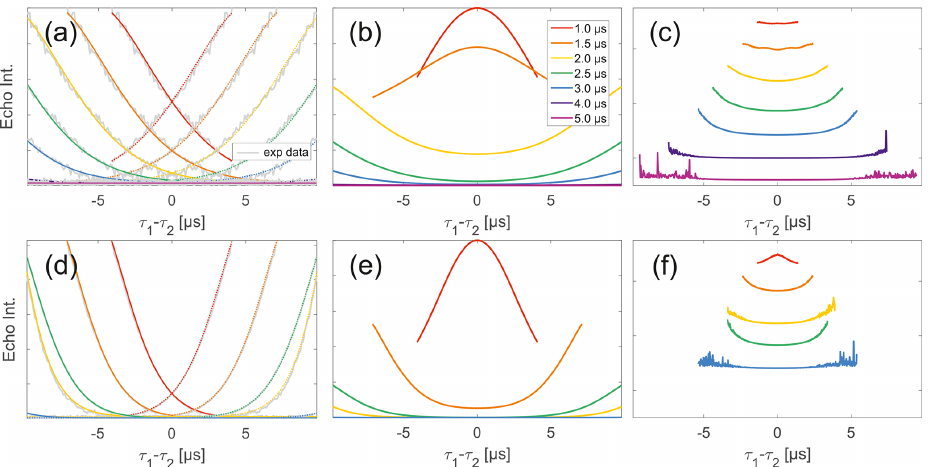
Figure 7. Analysis of two-pulse decay and refocussed echo data on 50µM biradicals in OTP. Panels (a) – (c) show data of nitroxide biradi- cal (3); (d) – (f) show data of trityl biradical (4). Two-pulse decays with corresponding SSE fits (grey), mirrored and aligned to reflect offsets τ 1 and τ 2 in SIFTER experiment (a, d) , product of the fits of the aligned decay traces (b, e) and result from division by corresponding SIDRE trace (c, f) (reflecting B S ) are shown. Traces in (c) and (f) are displayed in stack plots at arbitrary